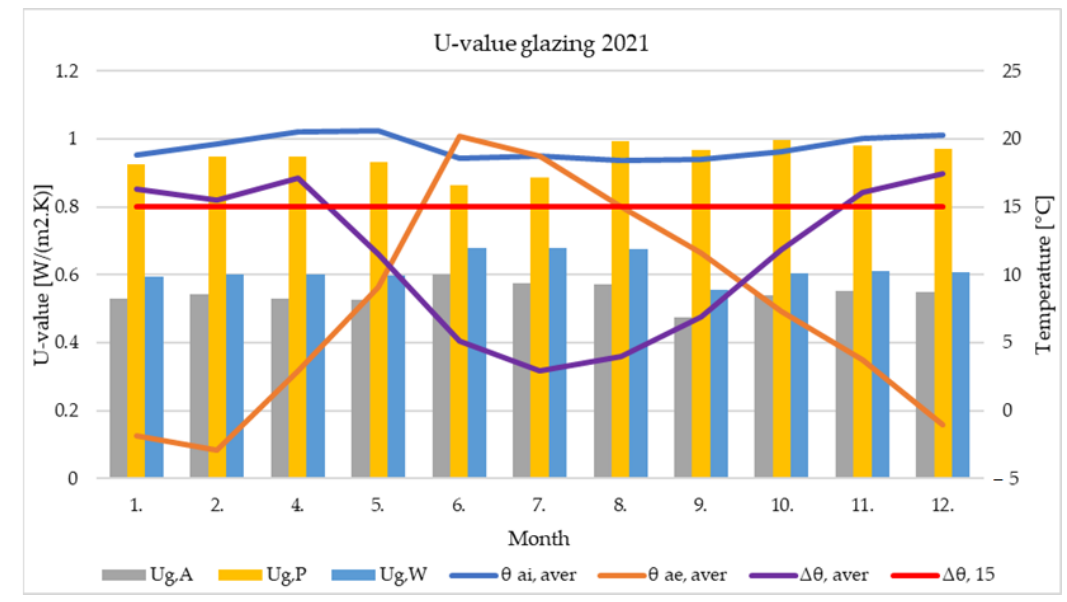
Figure 10. Average monthly U-values in 2021.